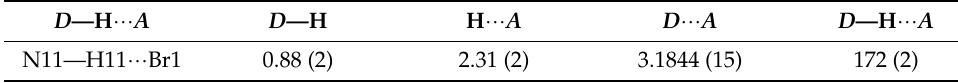
Figure 8. The intermolecular hydrogen bonds in compound 2 . Table 3. Strong hydrogen-bond geometry (Å, º) for 2